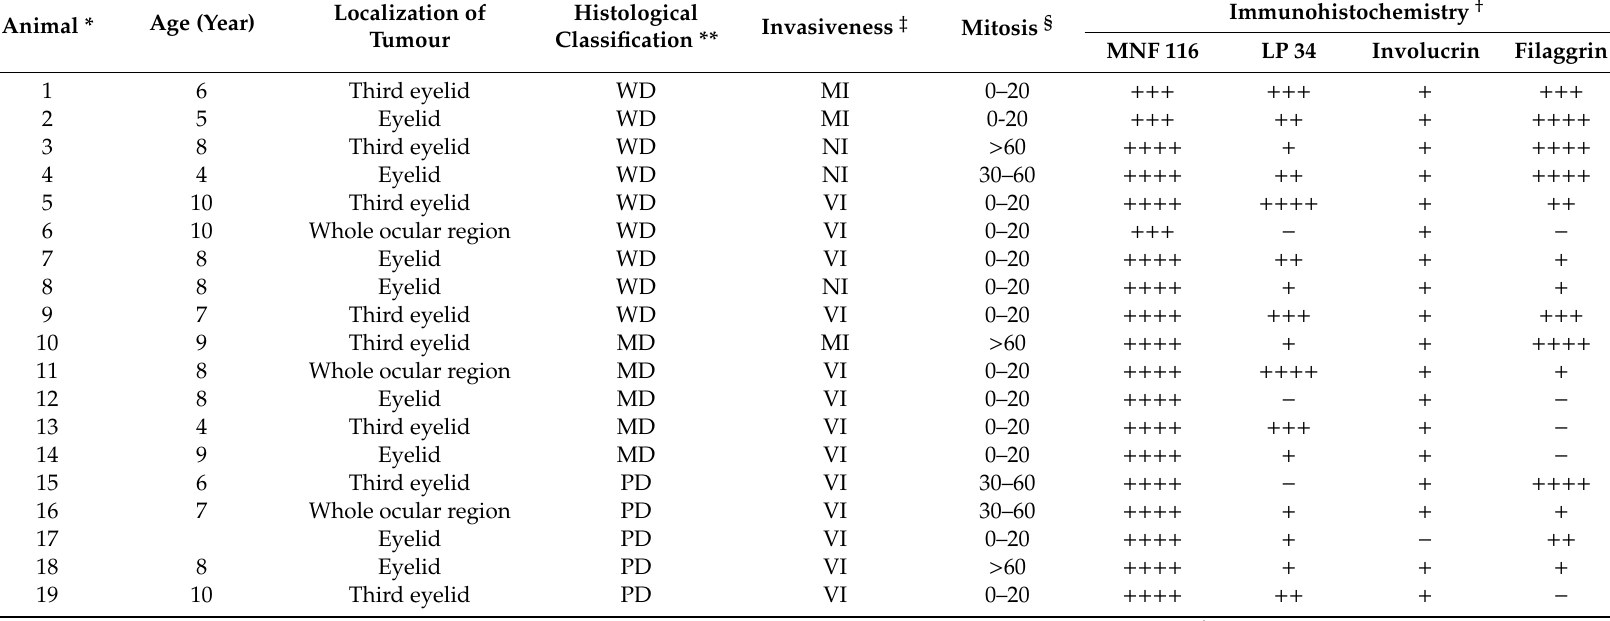
Table 3. Clinical data, tumour anatomic location, histological classification, mitotic index, and immunohistochemical